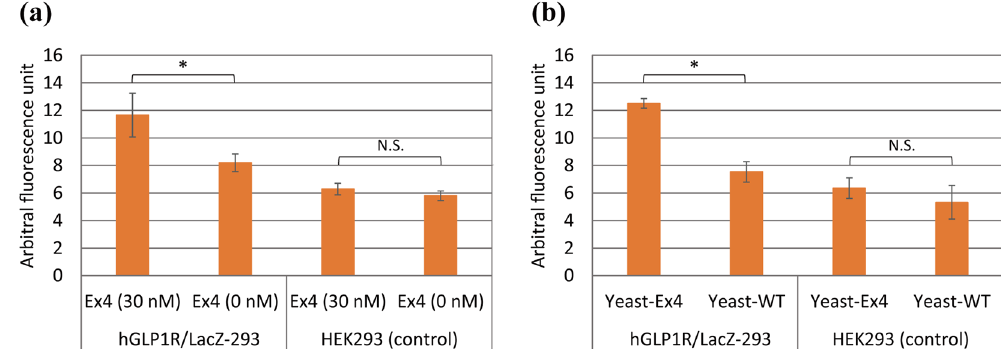
Figure 3. Functional cell-based assay using floating reporter cells. ( a ) Functional cell-based assay using authentic Exendin-4 (Ex4). The floating hGLP1R/LacZ-293 cells were suspended in a RPMI-1640 medium with or without 30 nM of authentic Ex4. Floating WT HEK293 was used as control. Values are mean ± SD (n = 3). Two-tailed Student’s t -test was used to compare two groups ( * p < 0.05). N.S., not significant. ( b ) Functional cell-based assay by co-culture with yeast cells secreting Ex4. The floating mammalian hGLP1R/LacZ-293 or WT HEK293 cells were co-cultured with yeast cells producing Ex4 (Yeast-Ex4) or WT yeast cells (Yeast-WT). Values were mean ± SD (n = 3). Two-tailed Student’s t -test was used to compare two groups ( * p < 0.05). N.S., not